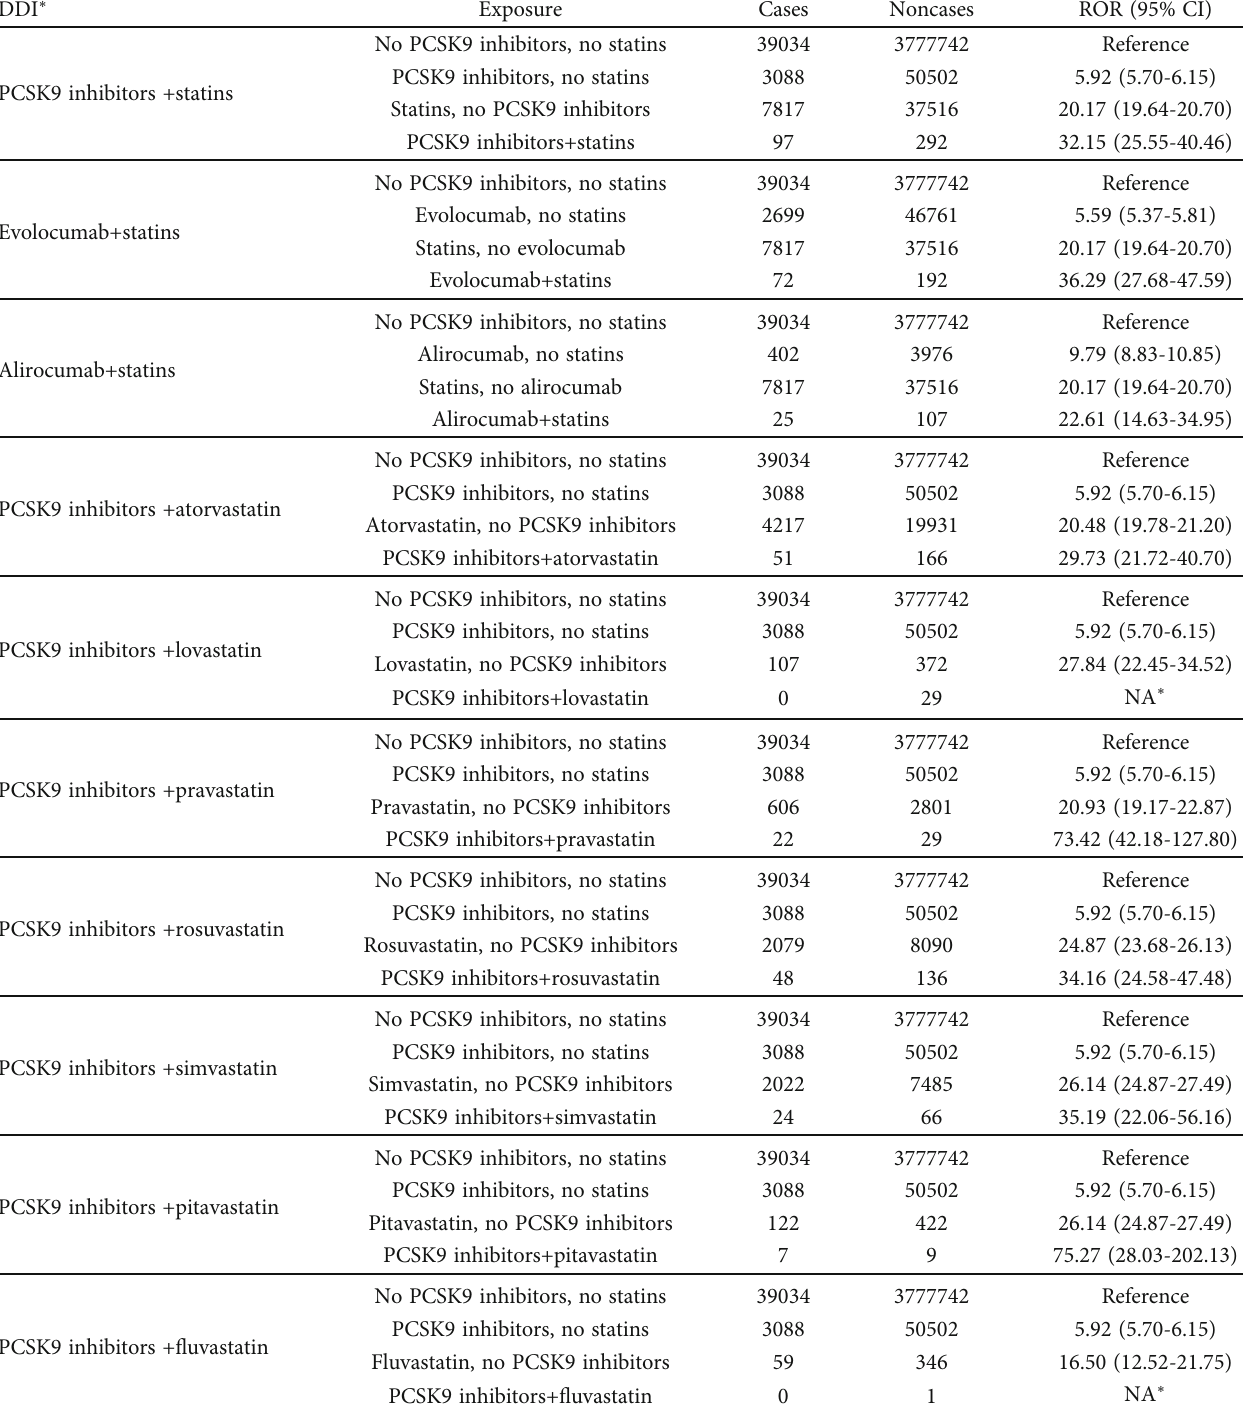
Table 2: Disproportionality analyses for the various PCSK9 inhibitor regimen and statin